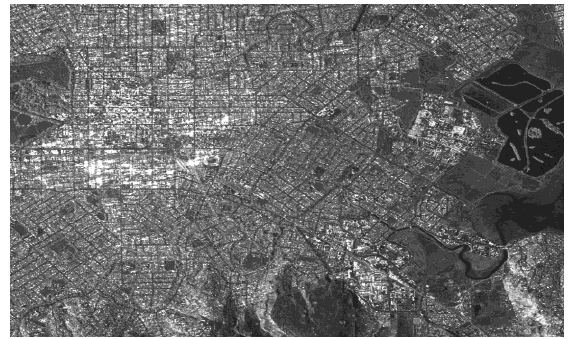
Figure 1. Average amplitude image of Christchurch before the earthquake of 22 February 2011